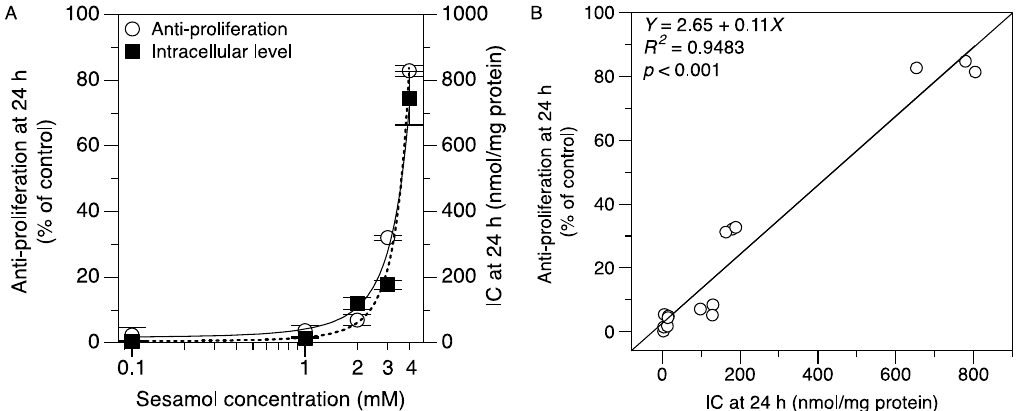
Figure 5. Correlation of intracellular concentration (IC) and antiproliferative effect of sesamol in SK-MEL-2 cells at 24 h. ( A ) The intracellular sesamol concentration ( ■ ) and antiproliferative effect ( ○ ) were fitted by an exponential model. ( B ) The linear regression analysis between intracellular concentration and the antiproliferation effect at 24 h ( R 2 = 0.9483, p < 0.001) using a Pearson correlation coefficient. The data were run in triplicate.